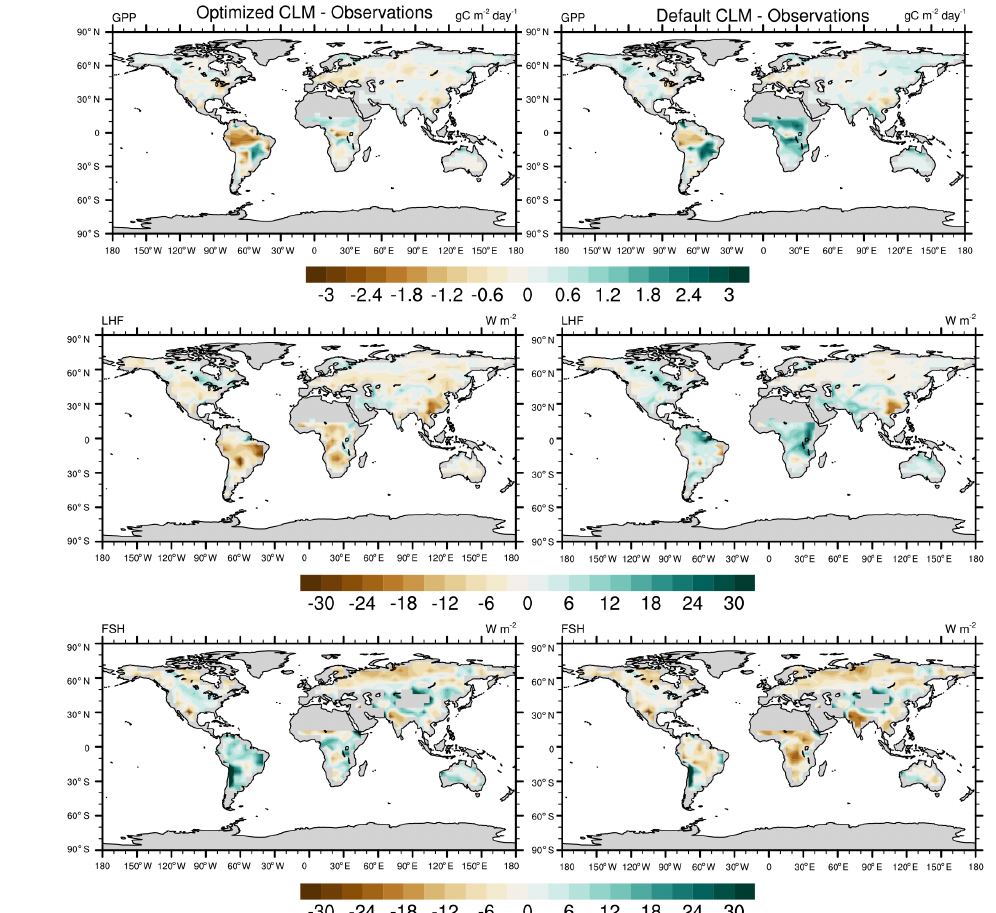
Figure 11. Annual mean bias maps comparing the CLM with optimized parameters (left column) and the CLM default configuration (right column) with observations. The differences are calculated for the calibrated output variables (GPP and LHF), along with sensible heat flux (FSH), an additional model output that we did not calibrate